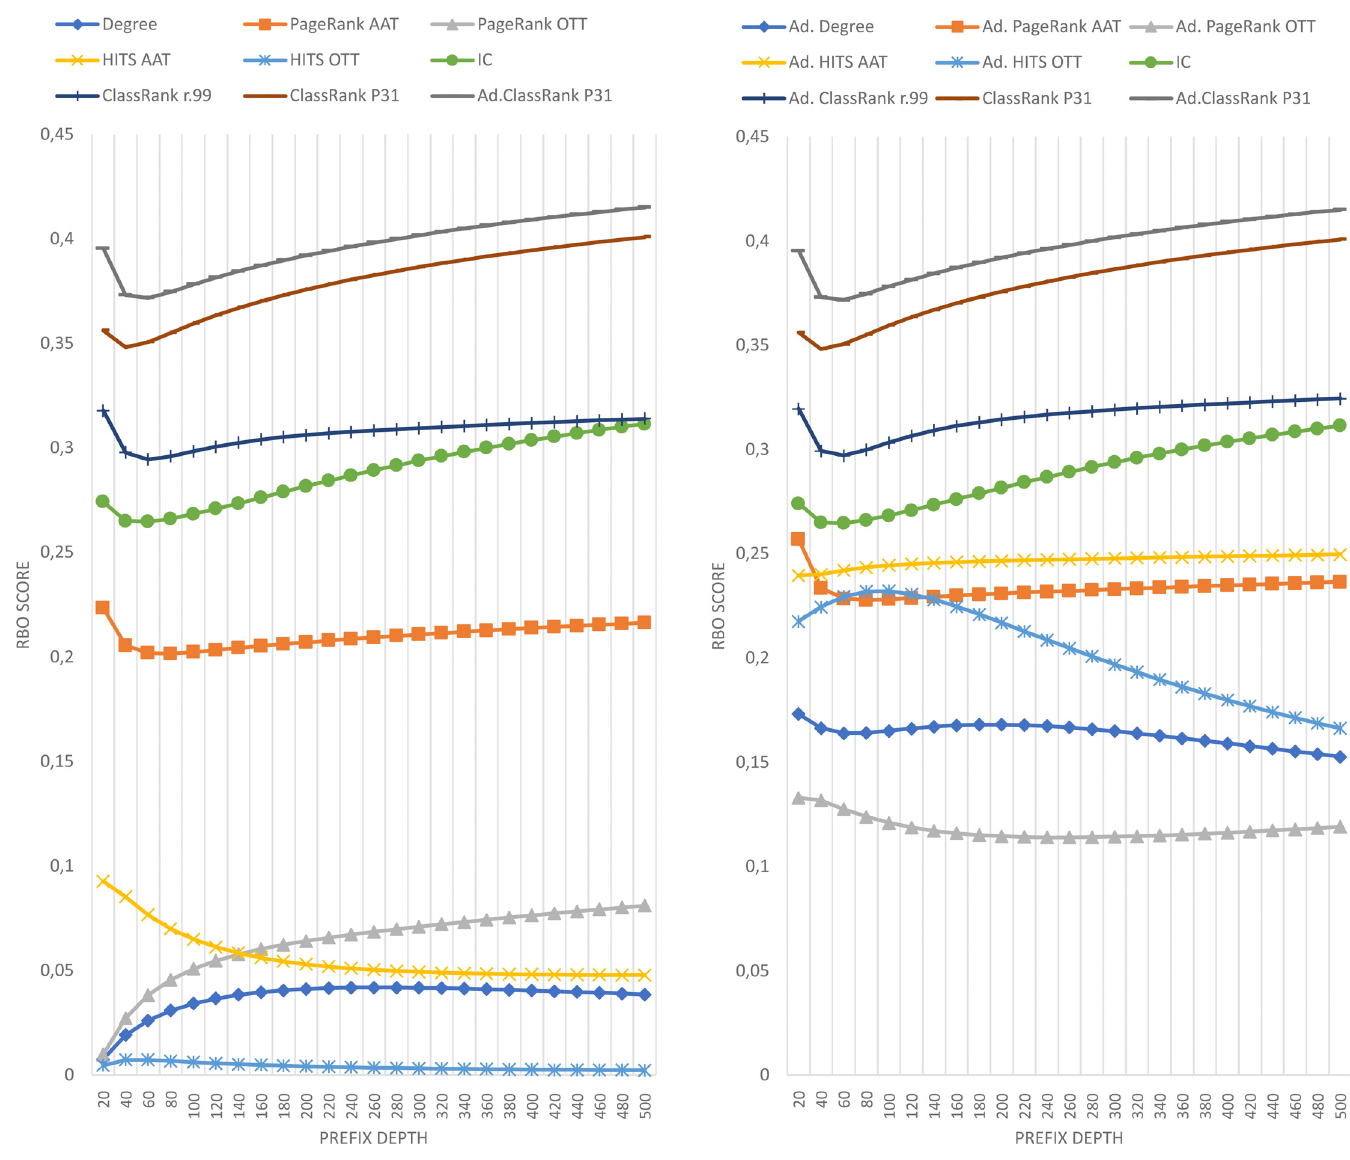
Fig 3. Comparison of techniques against EH log in